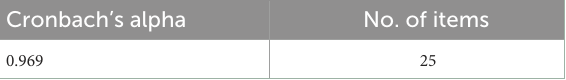
TABLE 4 Reliability statistics.